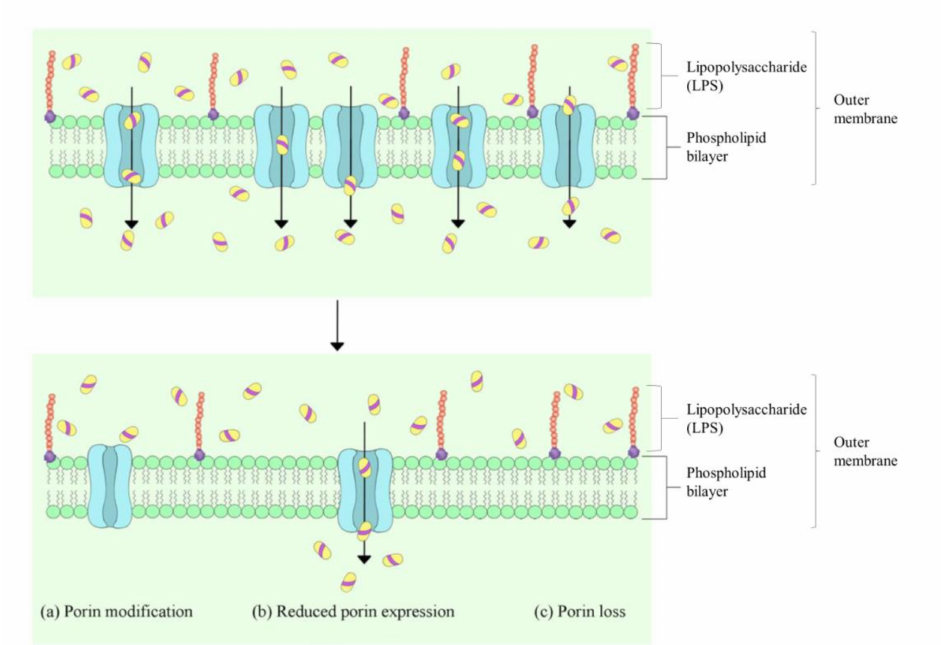
Figure 1. Generalised mechanisms for reduced porin-mediated outer membrane permeability in Gram-negative bacteria. Adapted from Yang et al. (2018)